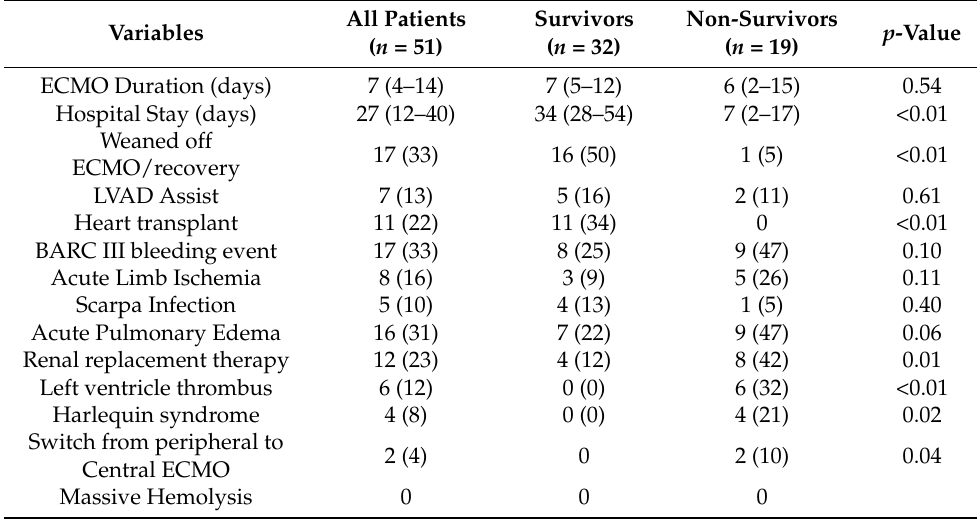
Table 2. Hospital survival-related